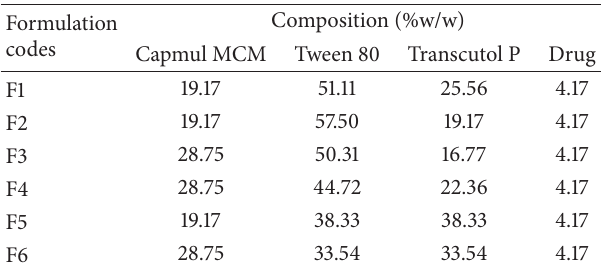
Table 1: Solubility studies of HCT in various vehicles. Table 2: Composition of developed